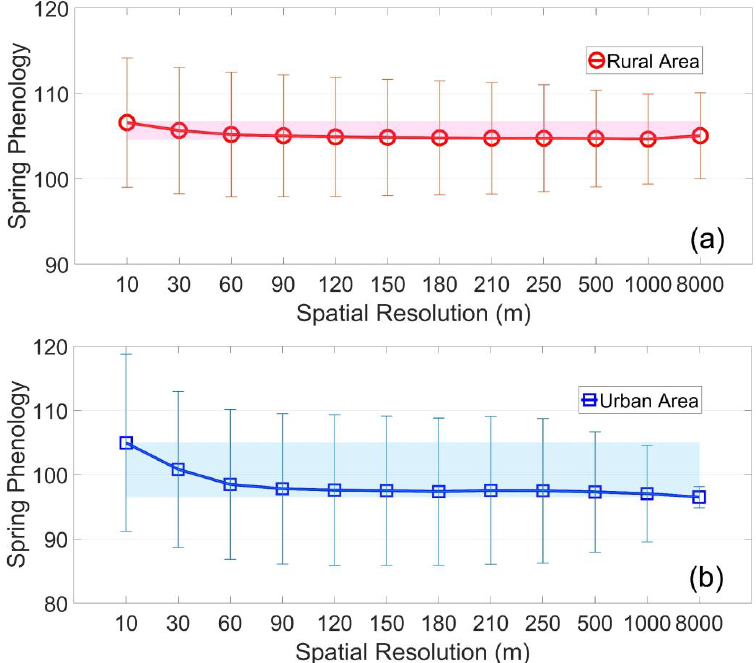
Figure 8. The average vegetation spring phenology in rural ( a ) and urban areas ( b ) at spatial resolutions from 10 m to 8 km.